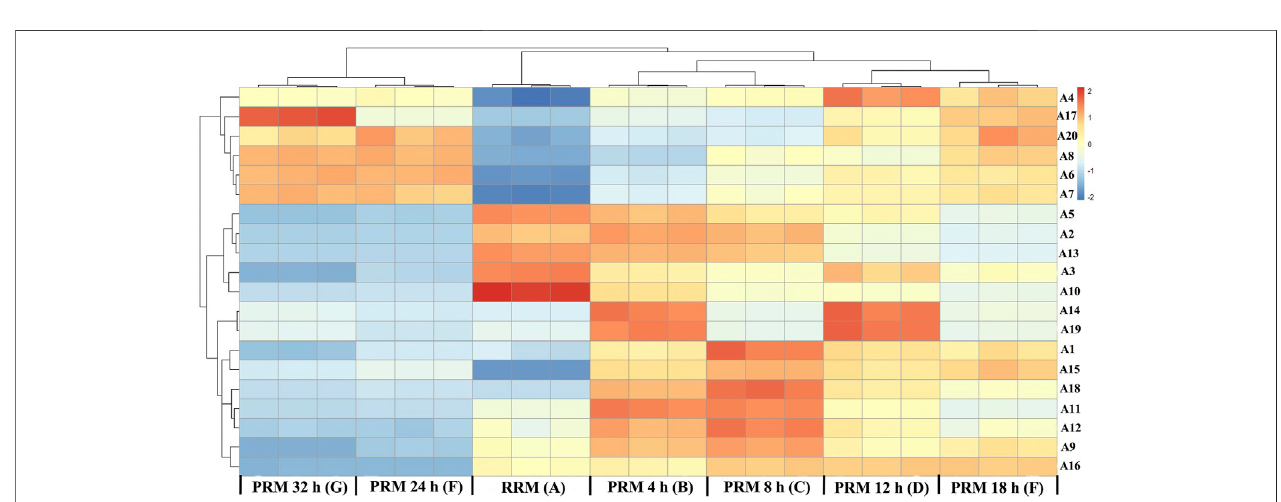
FIGURE 6 | Heat map of potential markers. Yellow in gradient presented the increases. Blue in gradient presented the decreases. (X-axis: (A) : raw Reynoutria multi fl ora (RRM), (B) : processed Reynoutria multi fl ora (PRM) 4 h, (C) : PRM 8 h, (D) : PRM 12 h, (E) : PRM 18 h, (F) : PRM 24 h, (G) : PRM 32 h; Y-axis: potentialmarkers, A4 , A17 , A20 , A8 , A6 , A7 , A5 , A2 , A13 , A3 , A10 , A14 , A19 , A1 , A15 , A18 , A11 , A12 , A9 , A16